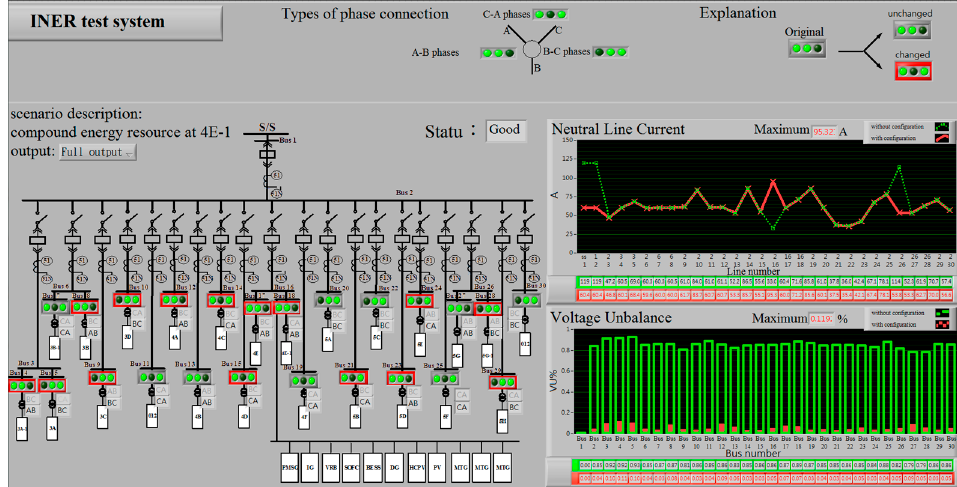
Figure 14. Comparison of the results of each Bus for the INER 30 ‐ Bus system considering reduction of voltage imbalance ratio and neutral line current with reconfiguration.